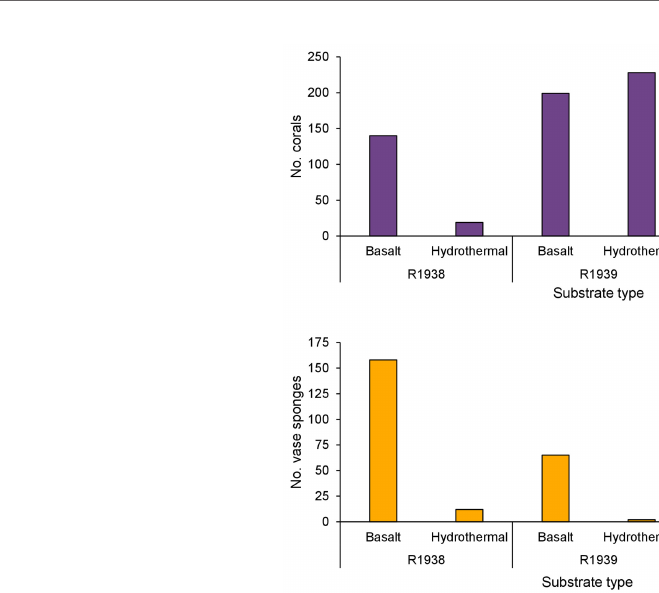
FIGURE 5 | The occurrence of deep-water corals and rossellid vase sponges on basalt and hydrothermally derived substrate on dives R1938, R1939, and R1940. Dive R1941 was not included as no deep-water corals and only three vase sponges were recorded. Dives were conducted by remotely operated vehicle ROPOS at the Endeavour segment of the Juan de Fuca Ridge, NE Paci fi c, in August 2016.